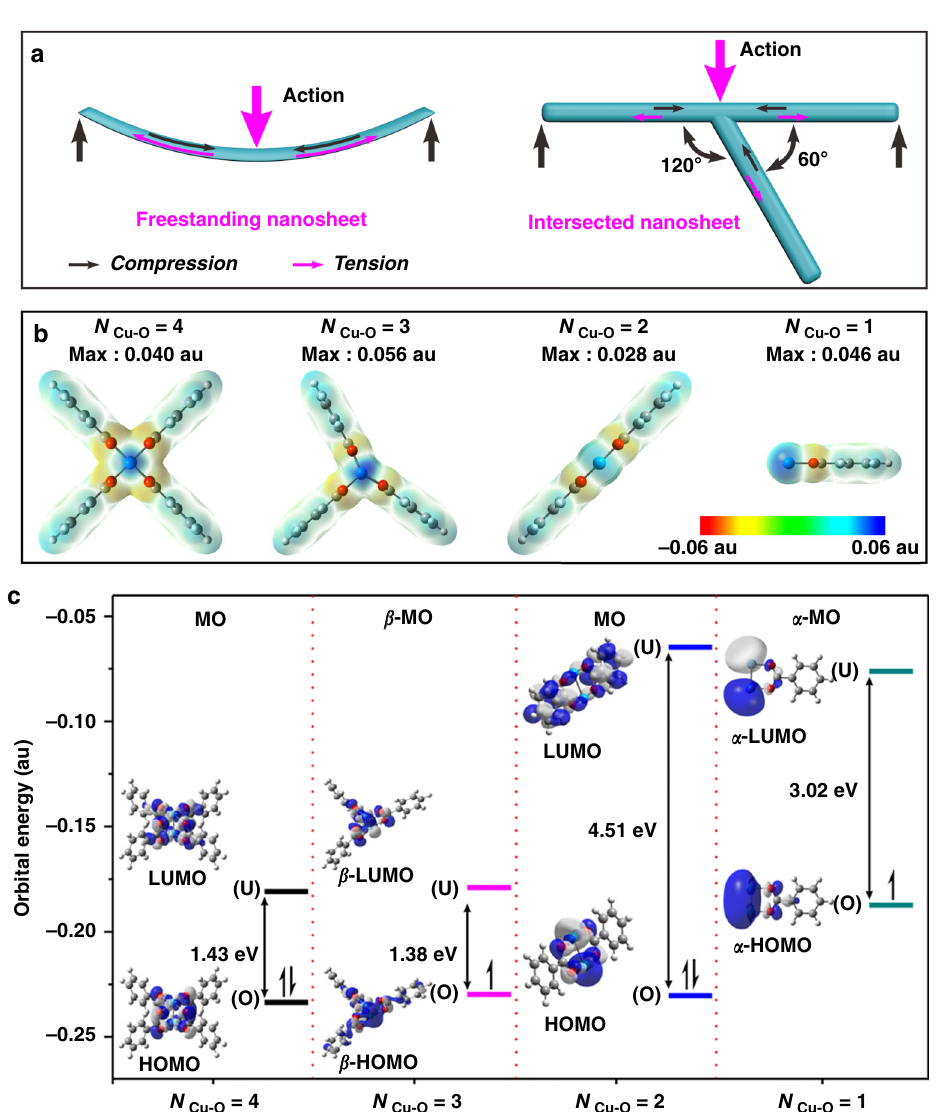
Fig. 1 Structural stability and physical properties of paddlewheel Cu 2 clusters. a A schematic overview of displacements for the freestanding metal – organic framework (MOF) nanosheet and intersected-nanosheet under the same acting force. b Electrostatic surface potential (ESP) maps of paddlewheel Cu 2 clusters. N Cu-O represents the paddlewheel Cu 2 clusters with different coordination numbers (CNs) of Cu – O (4, 3, 2, 1) (isovalue = 0.001 e per bohr 3 ). c The simulated frontier orbital energy levels and molecular orbital (MO) diagrams (isovalue = 0.02 au) of paddlewheel Cu 2 clusters with different CNs of Cu – O (4, 3, 2, 1). Only the β -MO and α -MO with smaller energy gaps are shown for the open-shell three- and one-coordinated copper (Cu) catalysts. Colour scheme for chemical representation: cyan, Cu; red, O; grey, C; white,